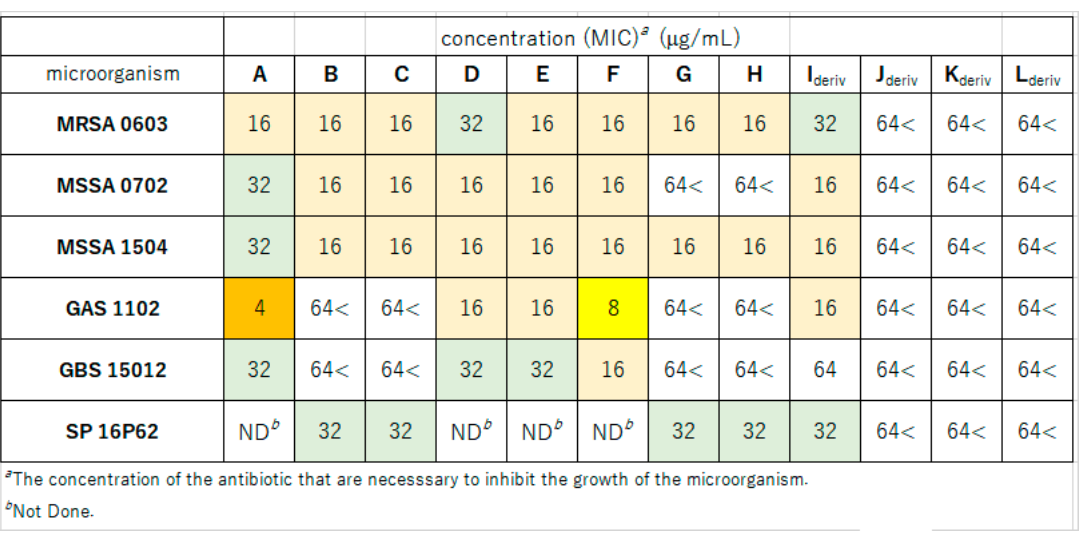
Figure 4. Antibacterial activity of eushearilide congeners A – H , I deriv , and related